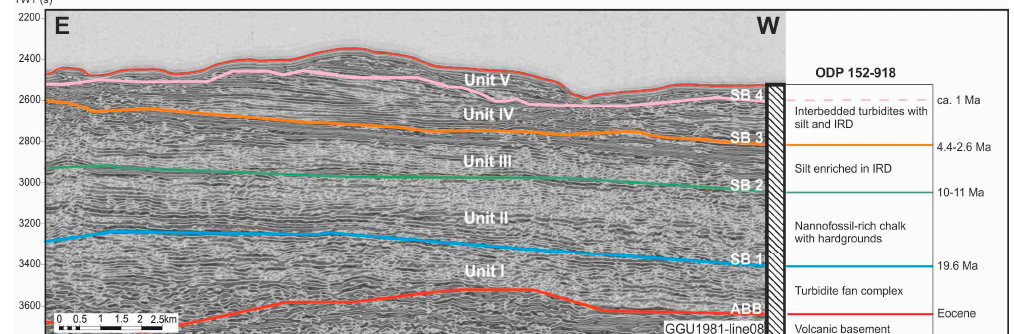
Figure 3. Overlay of a simplified core description and age model of the Ocean Drilling Programme (ODP) Leg 152 Site 918 core [3,8] on top of the across-slope orientated seismic profile crossing the core location. The core location is shown in Figure 1. The main seismic boundaries (SB 1–4 and ABB) that define a total of five seismic units (Unit I–V) are shown.